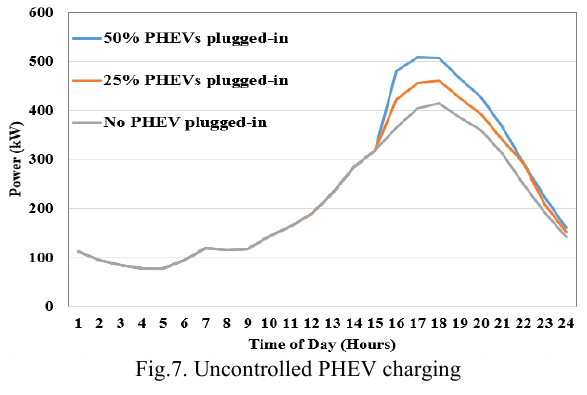
Fig.7. Uncontrolled PHEV charging